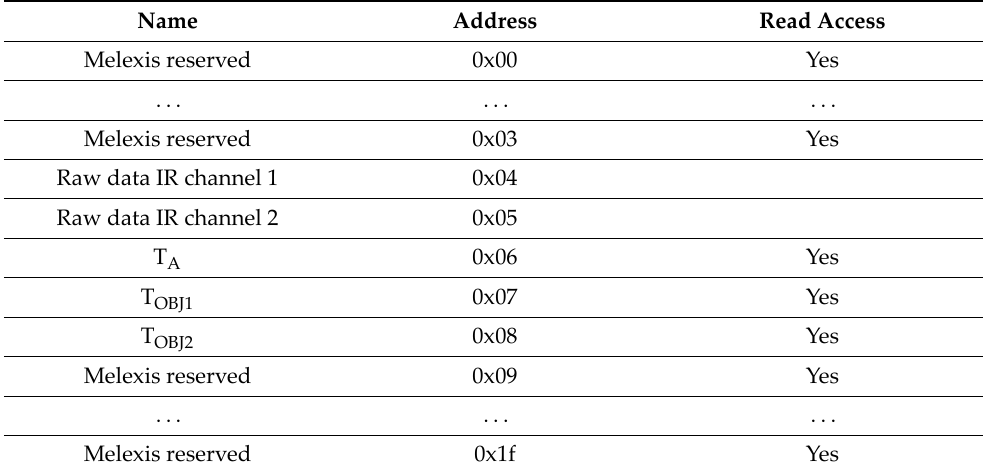
Table 1. Device configurations for input and output.